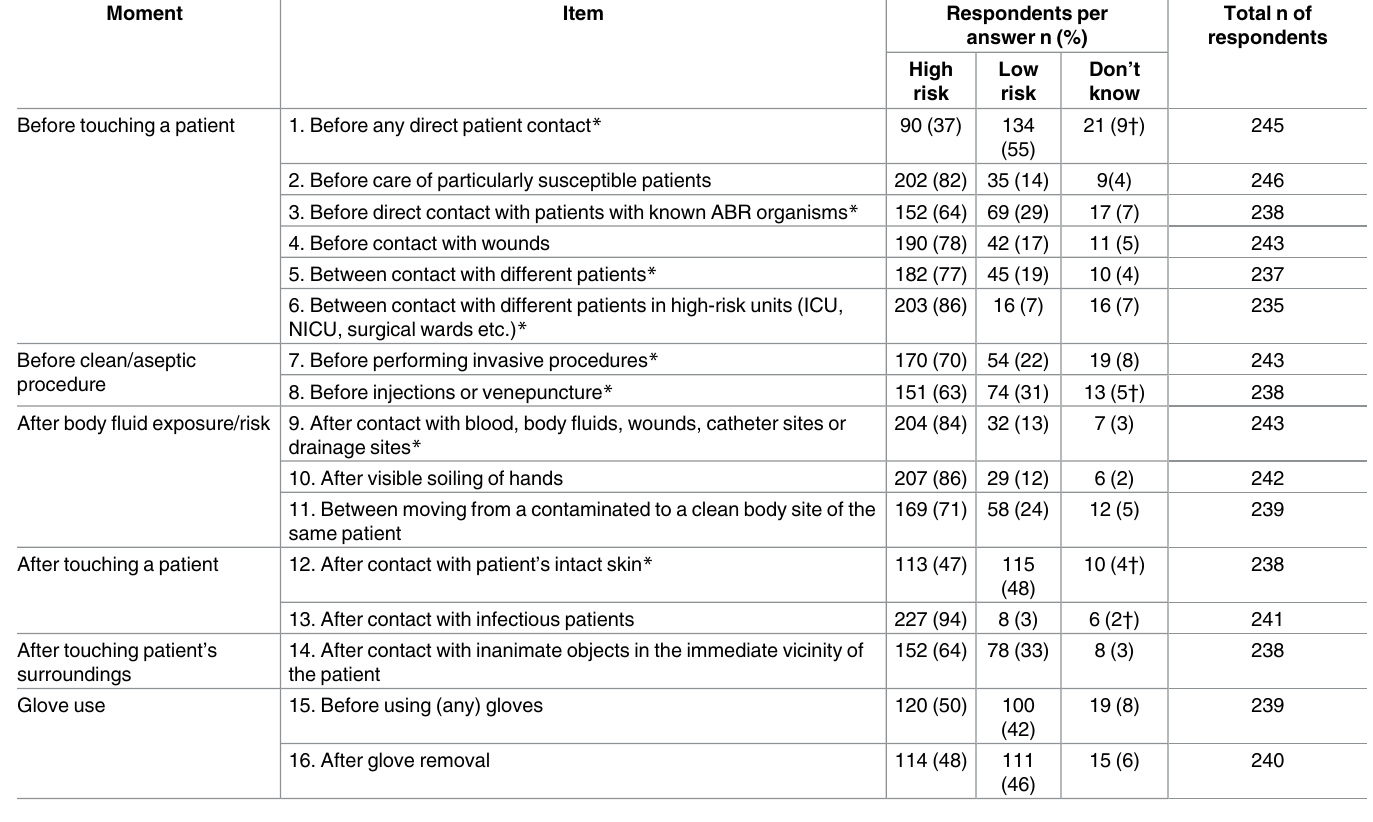
Table 4. Perceivedrisk of transmission of infectious agents amongst study population. Moment